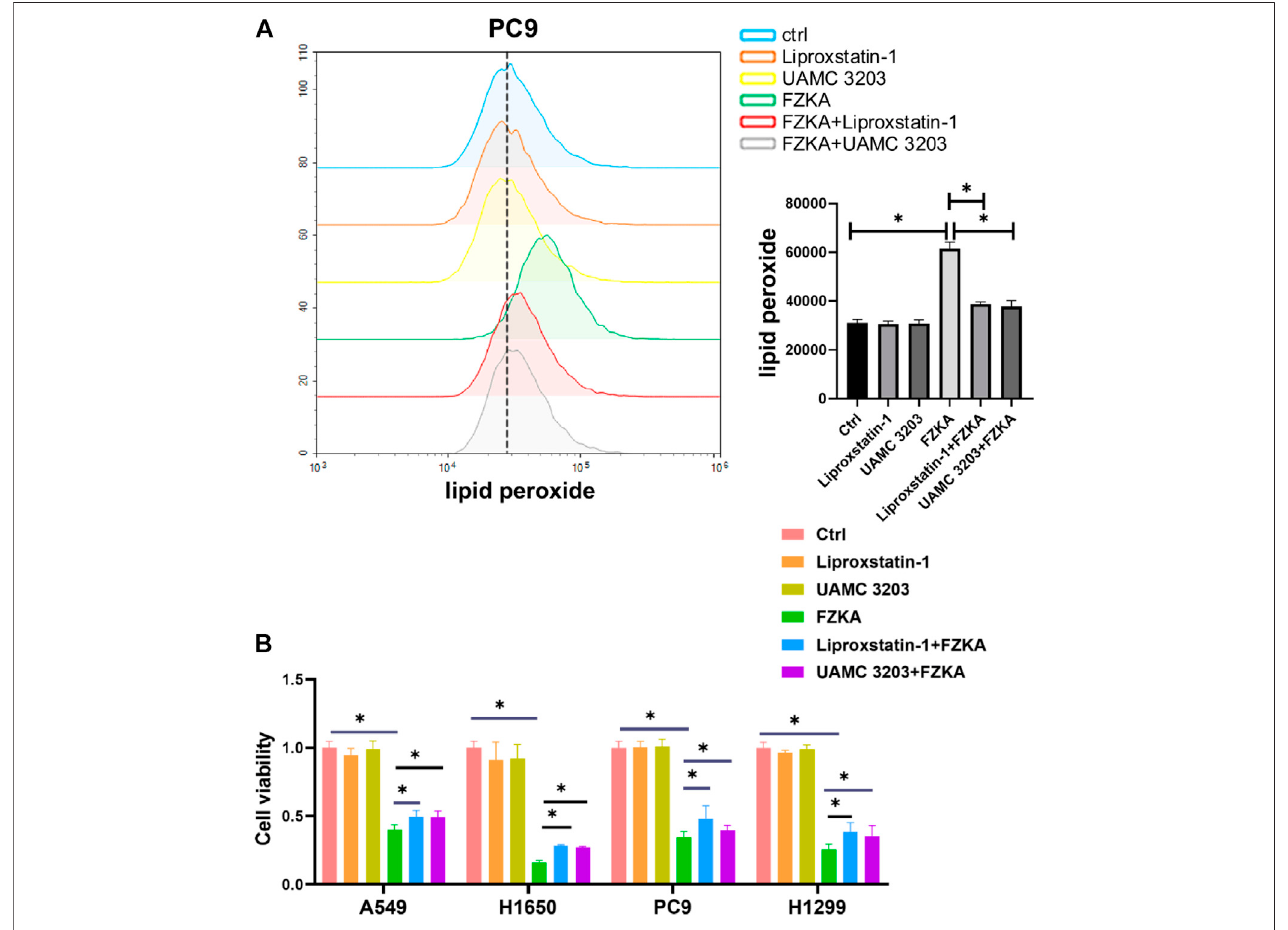
FIGURE 3 | Ferroptosis inhibitors including liproxstatin-1 and UAMC 3203 reversed the effect of FZKA. A, PC9 cells were treated as (A) FZKA (1.5 mg/ml), UAMC3203(25 nM)orliproxstatin-1(200 nM)for24 h,andstainedwithBODIPY ™ 581/591C11(10 μ M)for30 min.Theleveloflipidperoxidationwasdetectedby fl ow cytometry. Each point represents the mean ± SEM, n = 3, * p < 0.05. (B) , Cultured NSCLC cells were seeded in 96 well plate, FZKA (1.5 mg/ml in A549 and PC9 cells, 1 mg/ml in H1650 and H1299 cells), with UAMC3203 (25 nM), or liproxstatin-1 (200 nM) for 24 h. Cell viability was detected by CCK-8 assay, * p < 0.05.